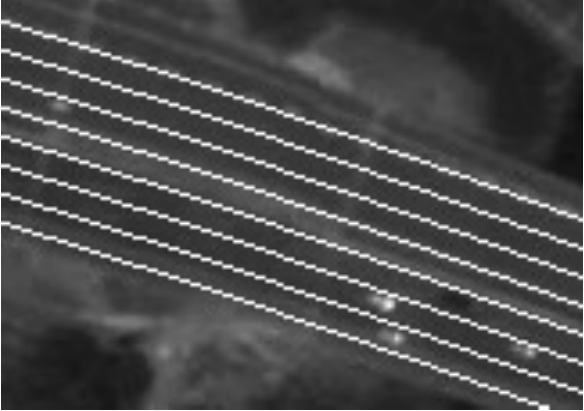
Figure 12: Result of lane boundary